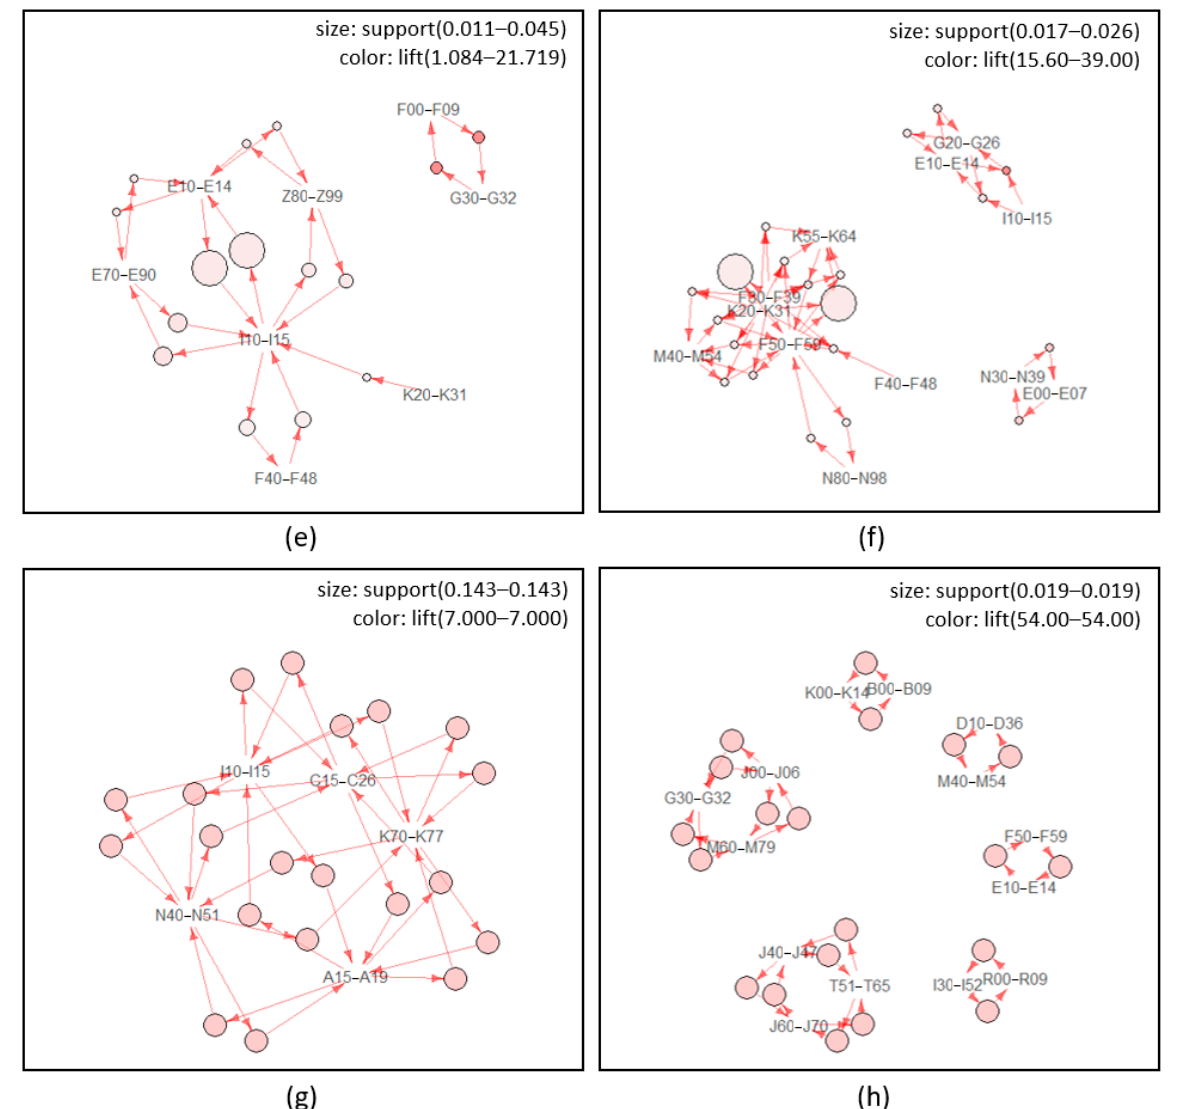
Figure 2. Network graph for comorbid diseases of mood disorders inpatients. ( a ) Mood disorders (F30–F39), ( b ) manic episode (F30), ( c ) bipolar affective disorders (F31), ( d ) depressive episode (F32), ( e ) recurrent depressive disorders (F33),